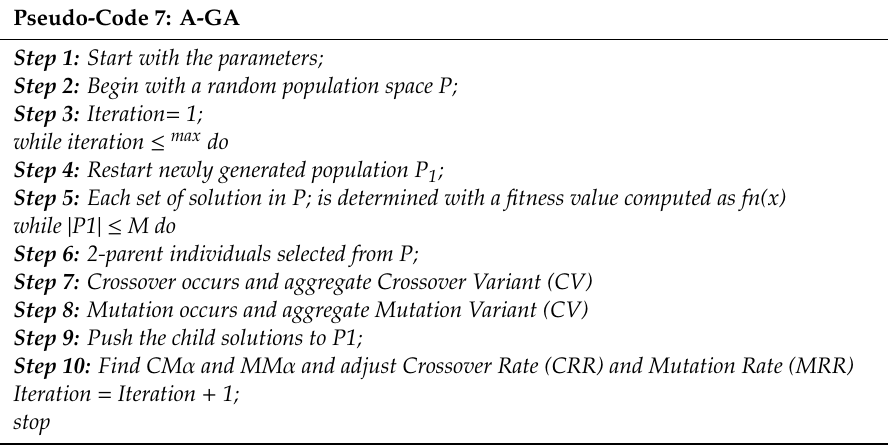
Table 10. Pseudo-code 7 for Adaptive Genetic Algorithm